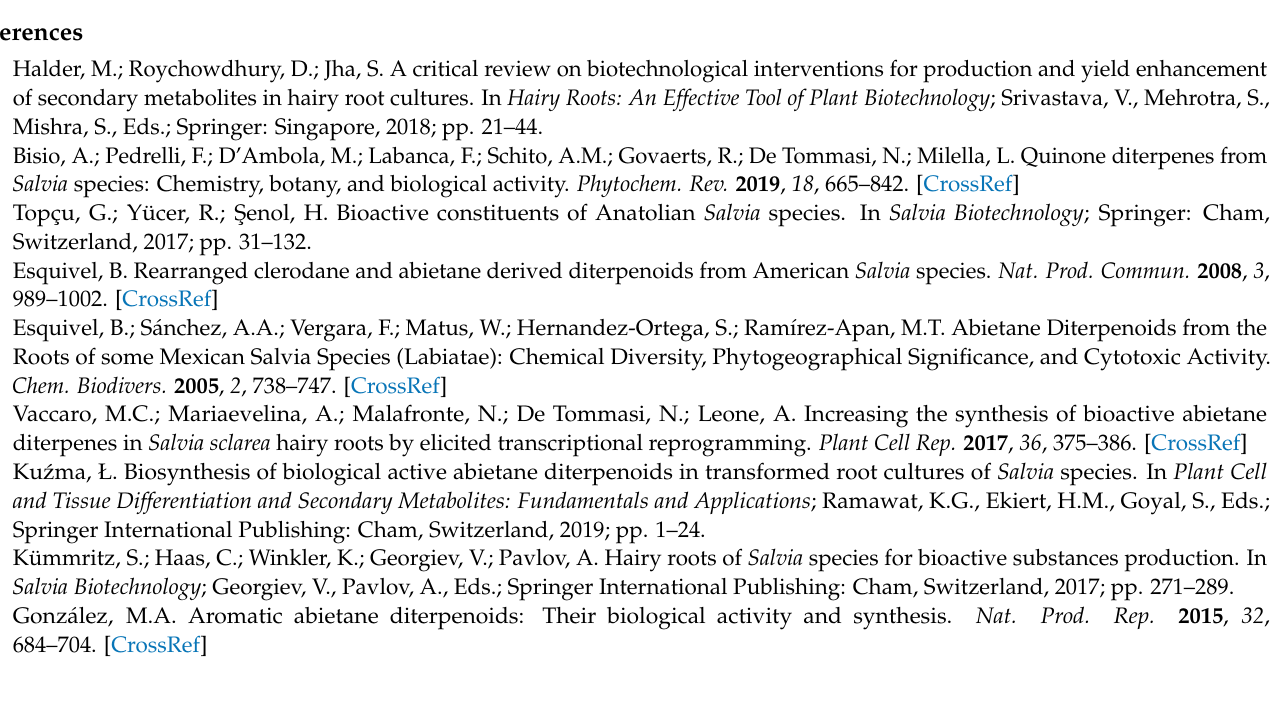
Supplementary Materials: Figure S1: Hairy root induction, Figure S2: Viability of hairy roots, Figure S3: Terpene content of hairy roots, Figure S4: Effect of different medium formulations on hairy root growth in bioreactor, Figure S5: Effect of sucrose concentration on hairy root growth, Figure S6: Growth curve of S. corrugata hairy roots, Figure S7: Medium conductivity, Table S1: Root selection after 30 days of induction from leaves explants of S. corrugata , Table S2: Daily increases of length of the principal root and branching index (number of branches in 1 month/30 days) of different clones from wild type ATCC 15834, Table S3: Daily increases of length of the principal root and branching index (number of branches in 1 month/30 days) of different clone strain LBA 9402. Table S4: Literature survey on Salvia species studied for hairy root establishment and production of secondary